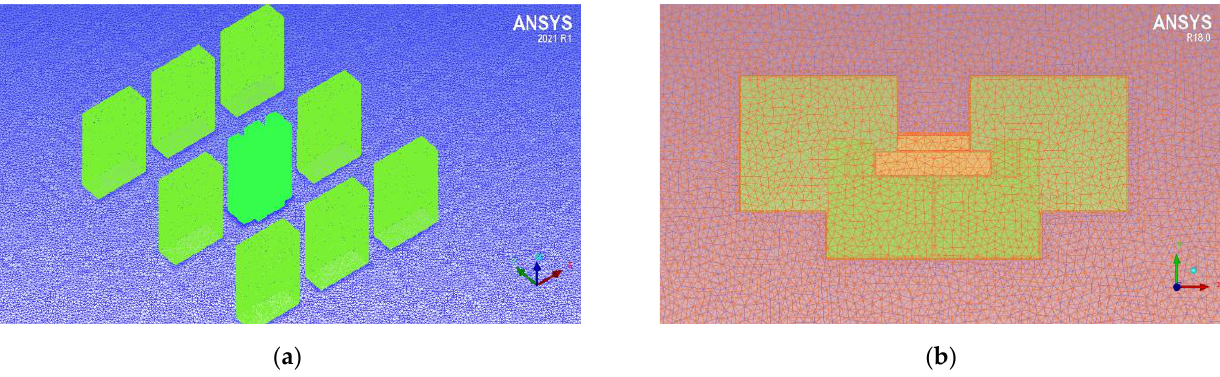
Figure 5. Model meshing: ( a ) outdoor environment grid meshing; ( b ) building area grid meshing.